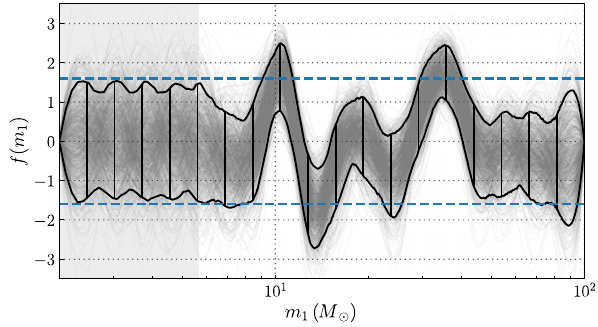
FIG. 12. The cubic spline function f ð m 1 Þ describing the perturbations to an underlying power law inferred with the PS model. The thin gray lines show 1000 draws from the posterior while the black lines show the knot locations (vertical) and the 90% credible region of the posterior. The dashed blue lines mark the 90% credible bounds of the Gaussian priors (centered on zero) imposed on each knot ’ s height. The shaded region covers any masses less than the 95th percentile of the marginal posterior distribution on m . Because the low-mass region of the mass min distribution is cut off and there are no observations there, the posterior in this region resembles the prior of the cubic spline